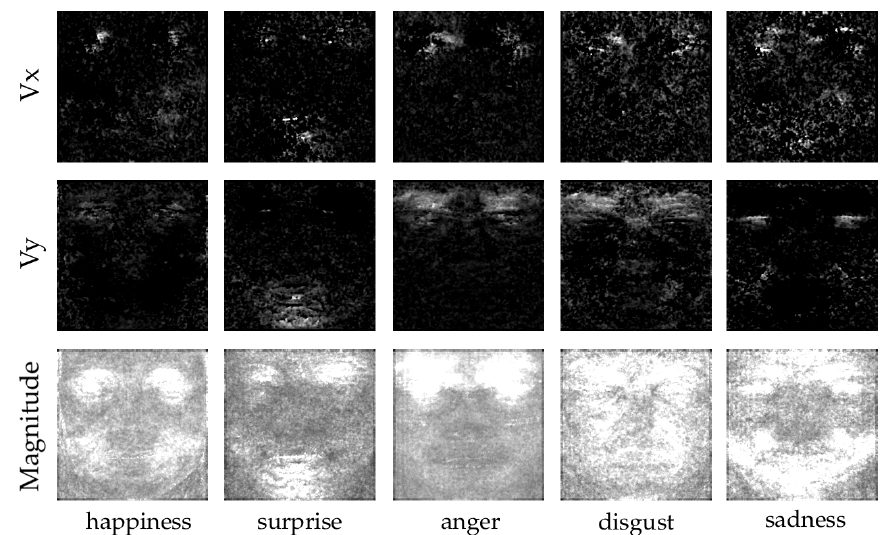
Figure 6. Average optical flow obtained in the dataset per ME class. Studied classes are in order from left to right: happiness, surprise, anger, disgust and sadness.